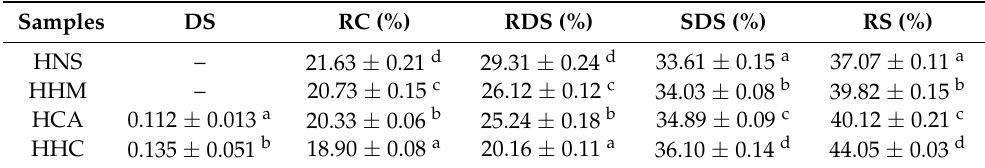
Table 1. Degree of substitution, relative crystallinity, in vitro digestibility of native, single-, and dual-modified Hausa potato